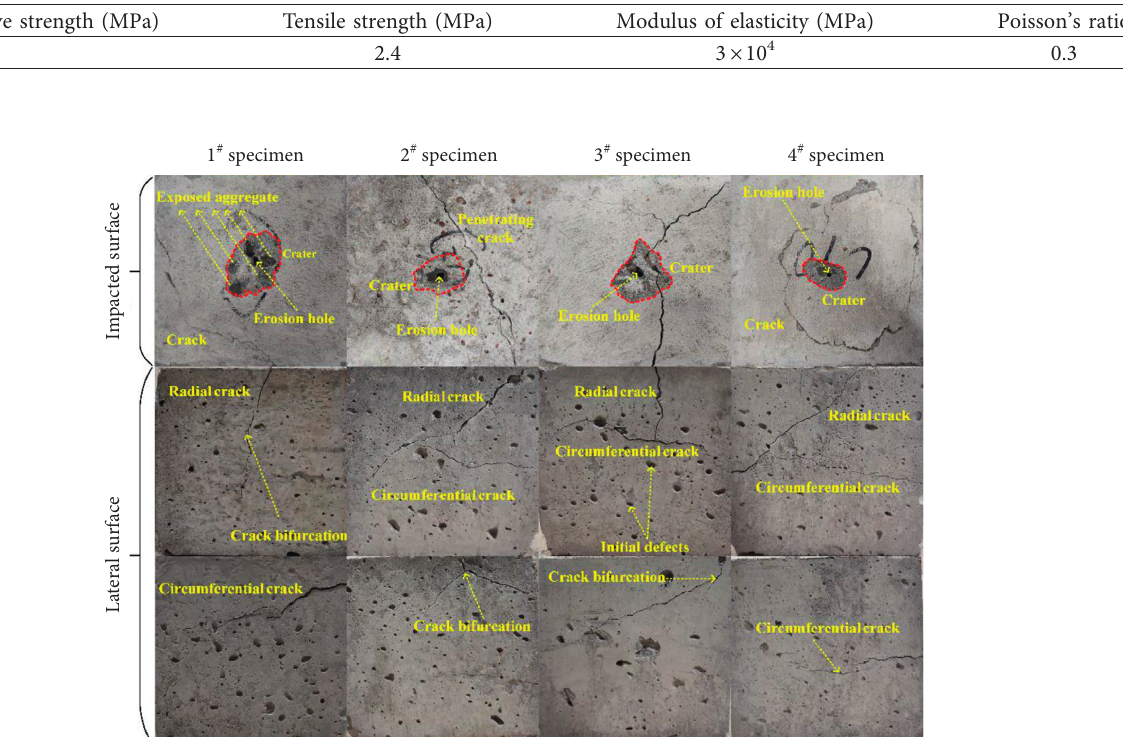
Table 2: Mechanical properties of the concrete specimens.